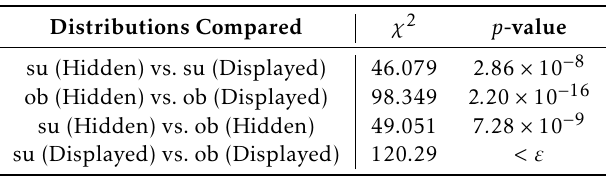
Table 2. Results of the Stuart-Maxwell χ 2 tests for analyzing participants’ self-reported trust in machine-generated and human-generated ratings.